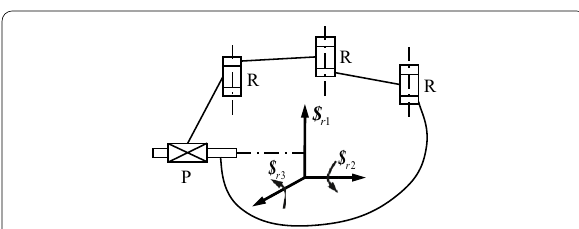
Figure 2 RRRP single-DOF closed-loop planar mechanism Figure 3 RRRP single-DOF closed-loop planar